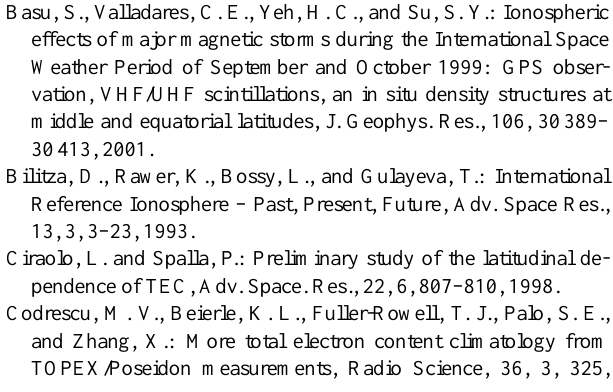
Fig. 9 Comparison between latitudinal profiles of GPS-derived TEC (black) Fig. 9. Comparison between latitudinal profiles of GPS-derived TEC (black) and IRI model (red) for April and IRI model (red) for April 2001.